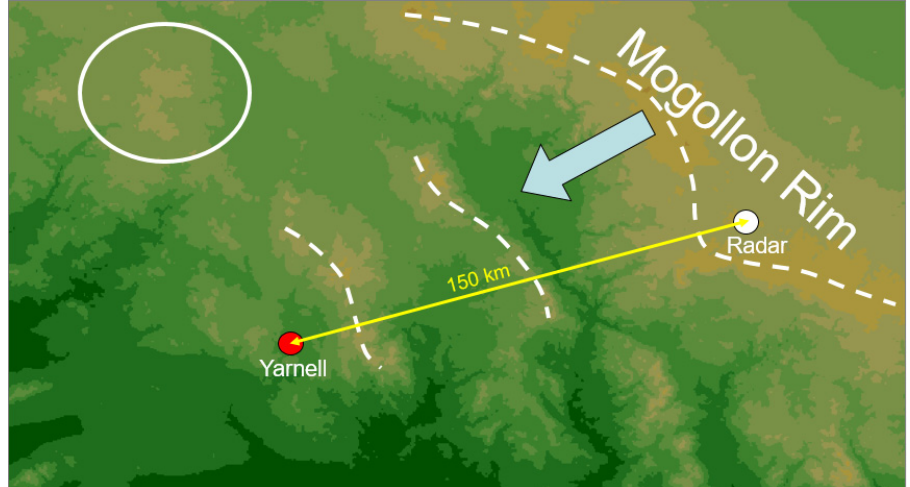
Figure 4. Highlighted features of the gust front model-generated elevation map. Elevations rise from 550 m (dark green) at the desert floor south of Yarnell to 2300 m (tan) at the Mogollon Rim escarpment (dashed line) which runs diagonally along the up- per right of the figure. Initial thunderstorm development occurred along the Mogollon Rim and over high ground (circle) located approximately 90 km north-northwest from Yarnell. Also factors in the results are two lesser mountain ranges (dashed lines) located between Yarnell and the Mogollon Rim at distances of 30 km and 80 km